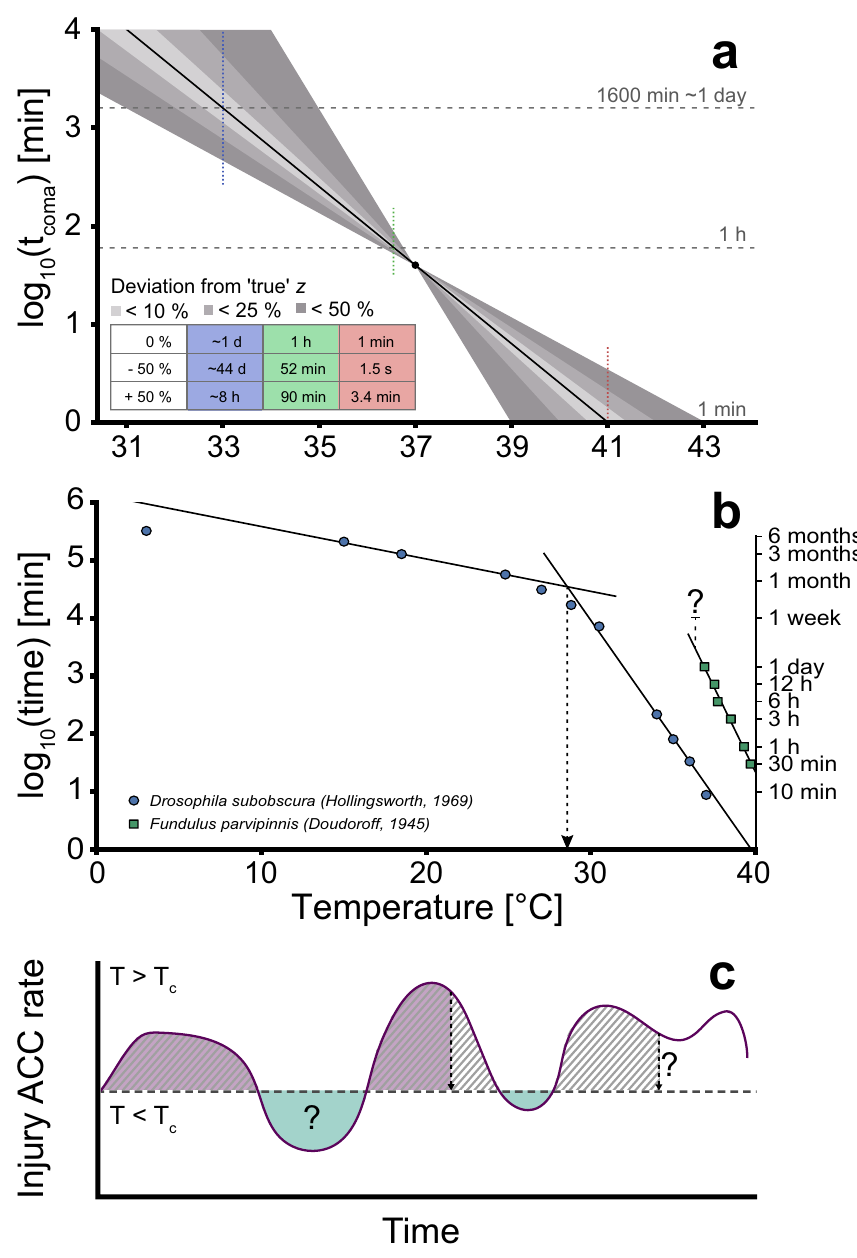
Figure 7. Potential pitfalls of extrapolation and the ambiguity of heat damage repair and hardening. ( A ) A theoretical TDT curve created from a single point (37 °C, 40 min) with an assumed ‘true’ value of z (black line). Grey areas show the TDT curve produced from the same point with deviations from the ‘true’ z of ± 10–50%. Horizontal lines are used to compare estimates of sCT max for 1 min, 1 h and 1600 min, while the vertical coloured lines are used to compare time estimates for the temperature of the sCT max for the ‘true’ TDT curve (calculated times in table) ( B ) The linearity of TDT curves should only be assumed within the time–temperature domain where it is parameterized, and it may vary in temperature and time between species. Data and TDT curve estimates for D. subobscura 22 and F. parvipinnis 25 . The dashed line for Fundulus represents the temperature with no mortality within the tested time domain (≤ 1 week). The dashed arrow indicates the breakpoint temperature found by 22 . ( C ) Hypothetical fluctuating temperature profile where temperature (and accordingly the injury accumulation (ACC) rate) fluctuate around the incipient lethal temperature T c (the temperature where injury accumulation rate surpasses injury repair rate, i.e. net injury accumulation). The purple area indicates the part of the temperature profile that would attain the critical amount of injury, under the assumption that no repair or hardening (i.e. processes counteracting injury accumulation) takes place in the green shaded areas. However, when little is known about the processes counteracting injury accumulation and their relation to temperature, it is difficult to predict when coma onset occurs (hatched